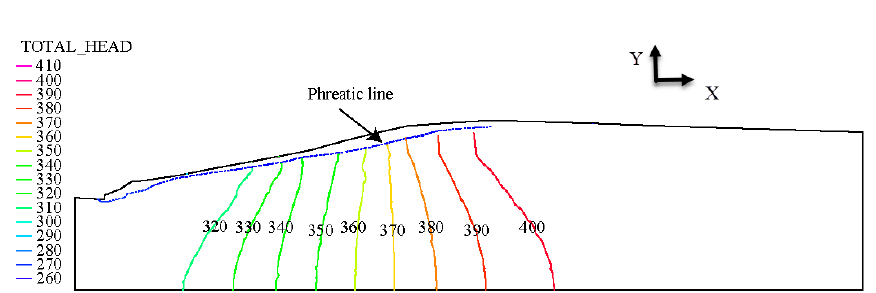
360370380390400410420 Figure 9. The position of the phreatic line under different dry bench length. 300310320330340350 400